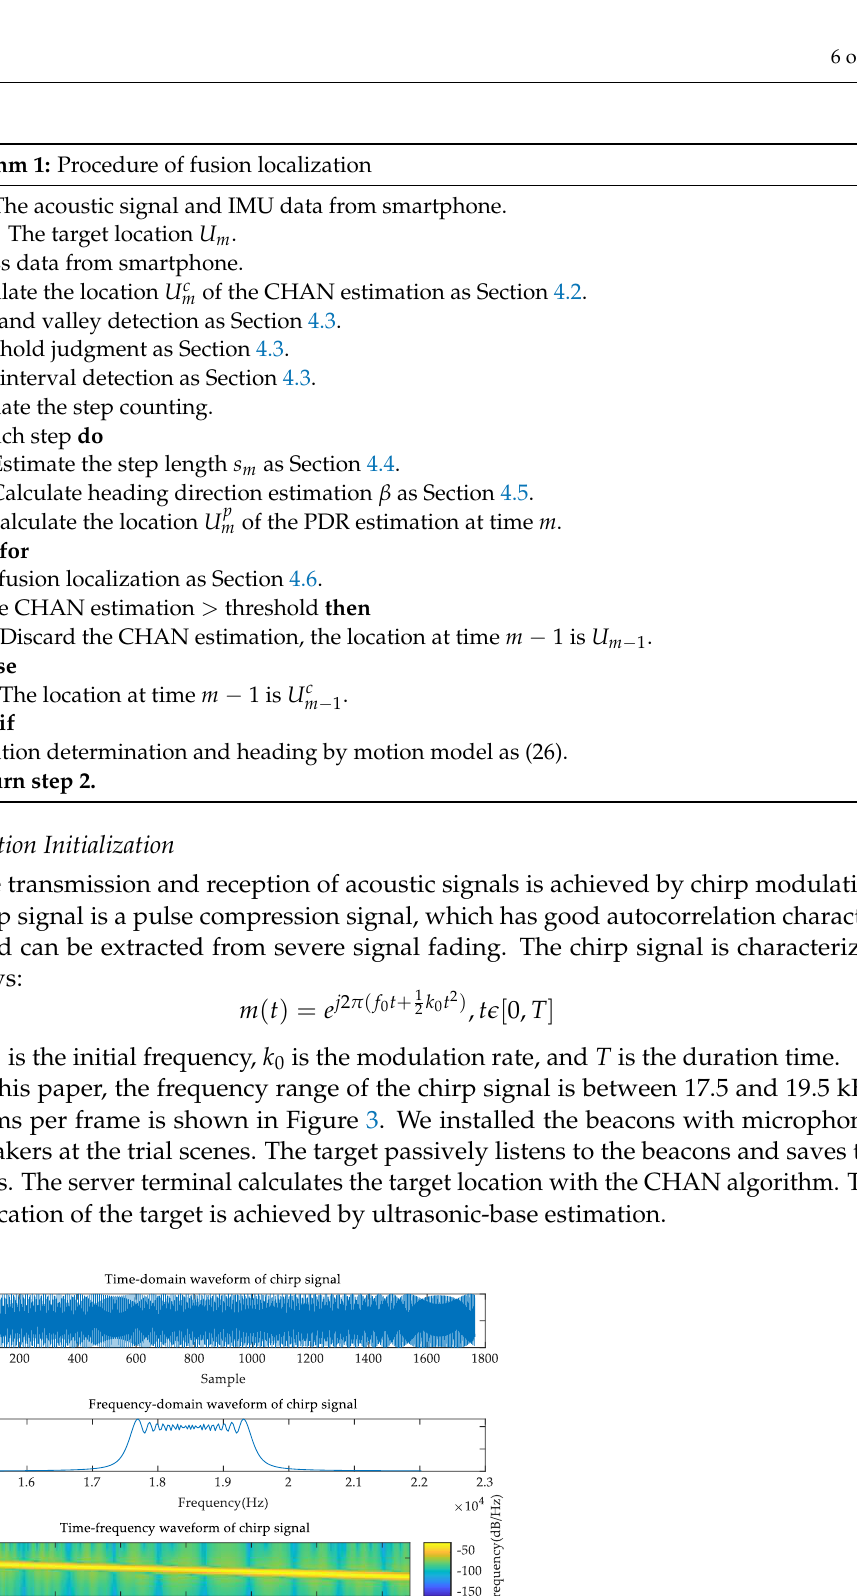
d 3 Figure 4. Spatial geometric location map with three beacons (𝐴 1 , 𝐴 2 , 𝐴 3 ) and the target T . The distance difference 𝑑 𝑖1 between the i -th beacon and the target can be calculated as follows: